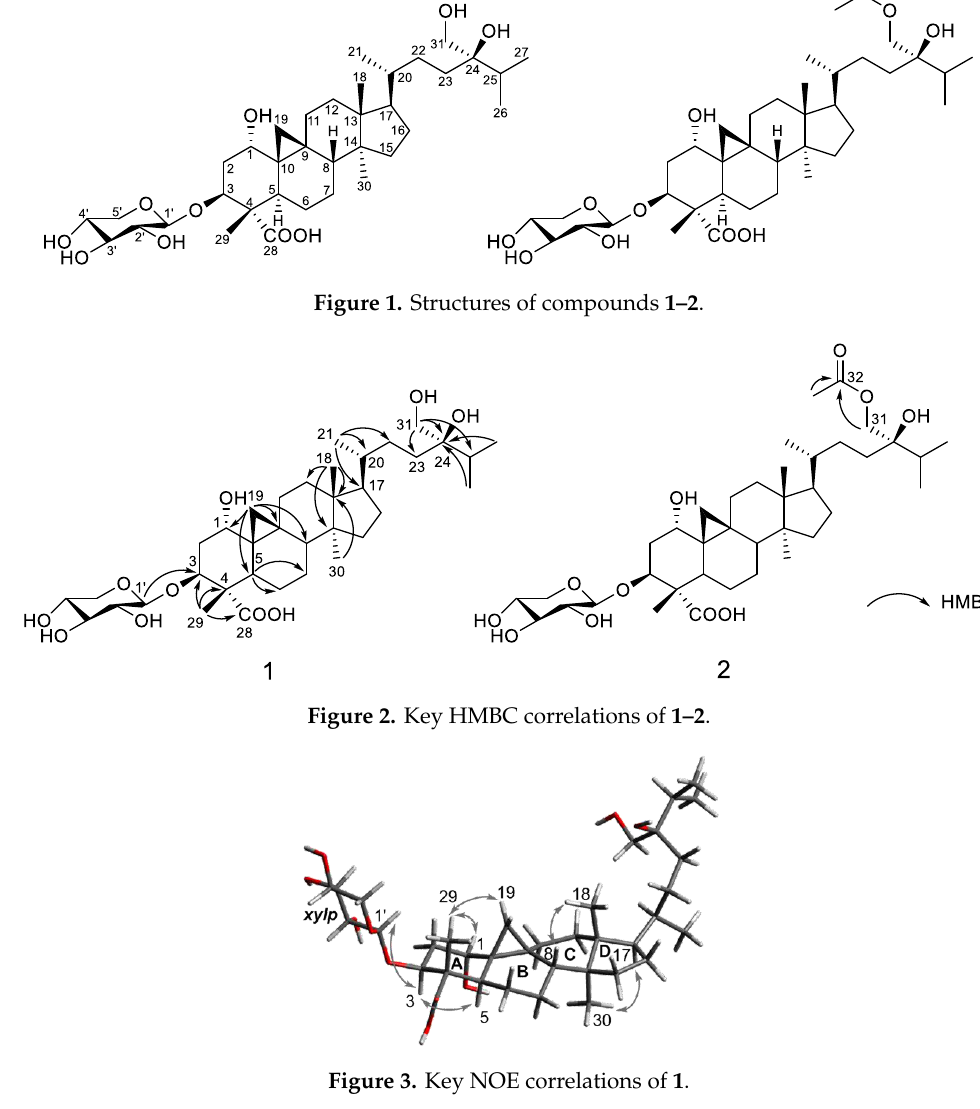
Figure 3. Key NOE correlations of 1 .